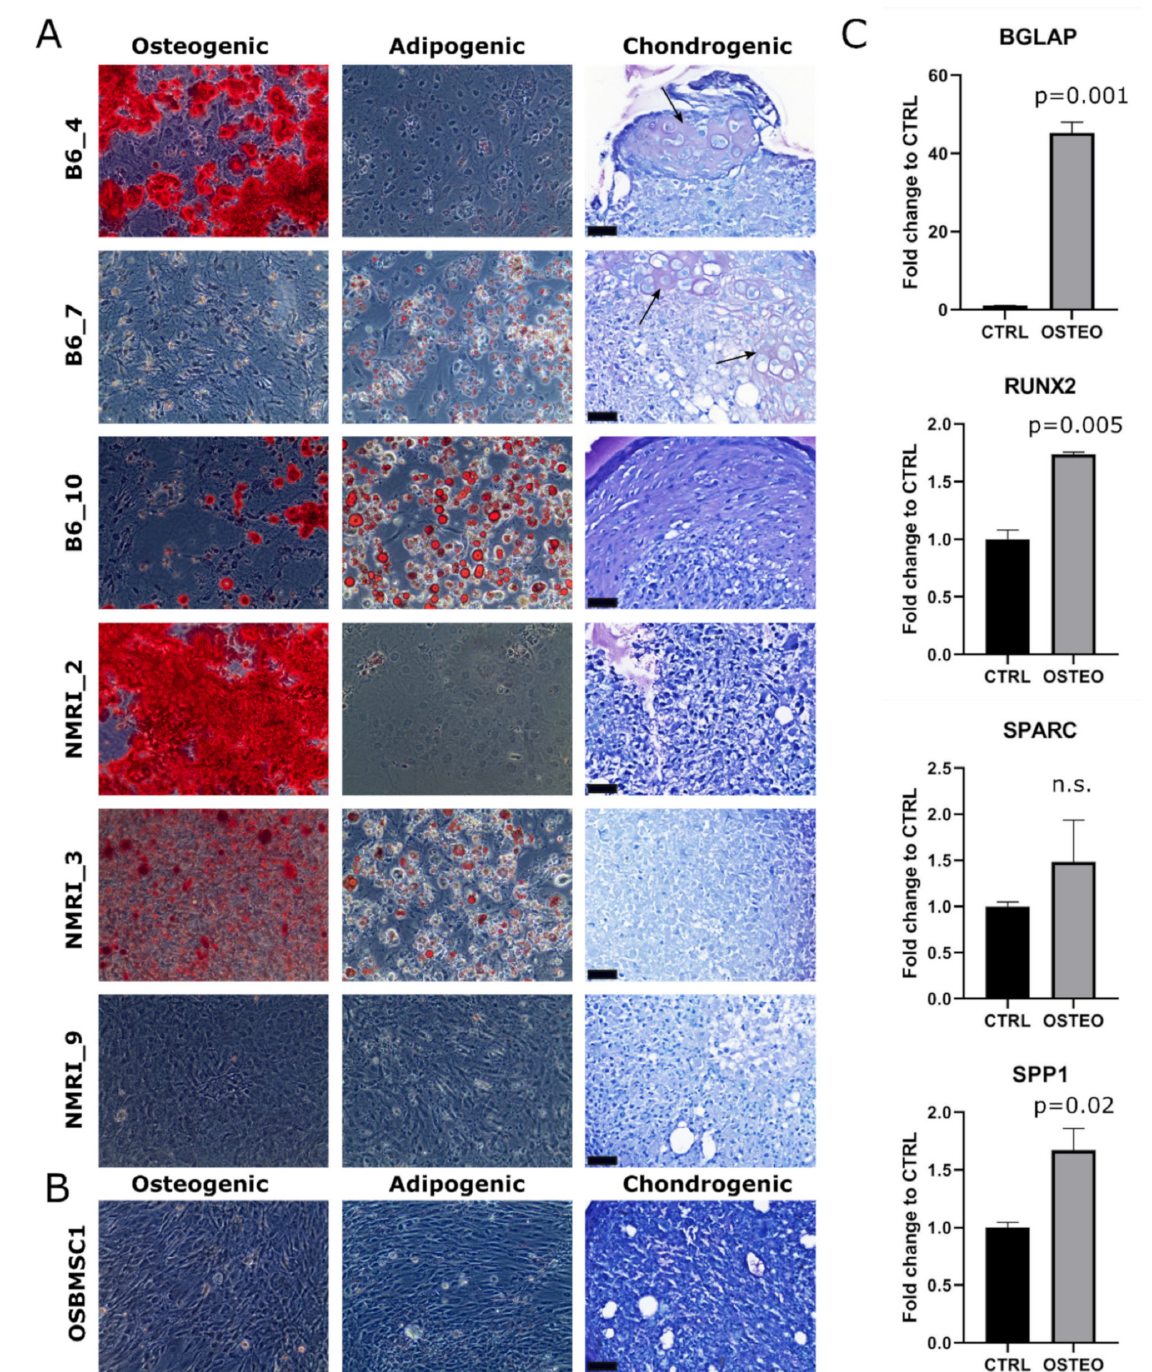
Figure 3. Trilineage differentiation of late passage murine and canine MSCs. Osteogenic, adipogenic and chondrogenic differentiation of ( A ) late passage murine MSCs and ( B ) late passage canine MSCs of OSBMSC1 was assessed by Alizarin Red (Magnification 100 × ), Oil Red O (Magnification 100 × ), and Toluidine Blue staining, respectively, and was highly variable among donors. For Toluidine Blue staining, arrows indicate metachromatic staining, indicative for cartilaginous matrix. Scale bar represents 40 µ m. ( C ) Osteogenic gene expression markers ( BGLAP, RUNX2, SPP1 ) were significantly upregulated in late passage OSBMSC1 treated with osteogenic stimuli for 3 weeks (OSTEO), compared to non-treated MSCs (CTRL). Bars represent the mean of one experiment performed in triplicate ± standard